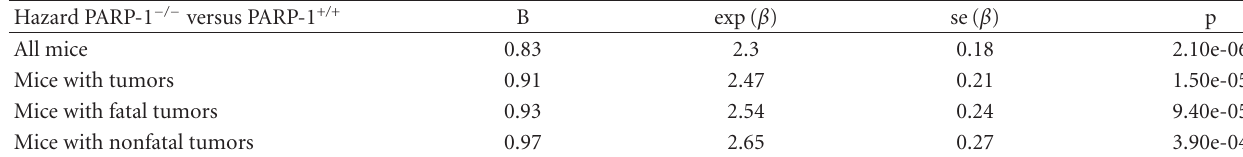
Table 5: The Cox’s model parameters for di ff erent subgroups of PARP-1 + / + and PARP-1 − / − mice.